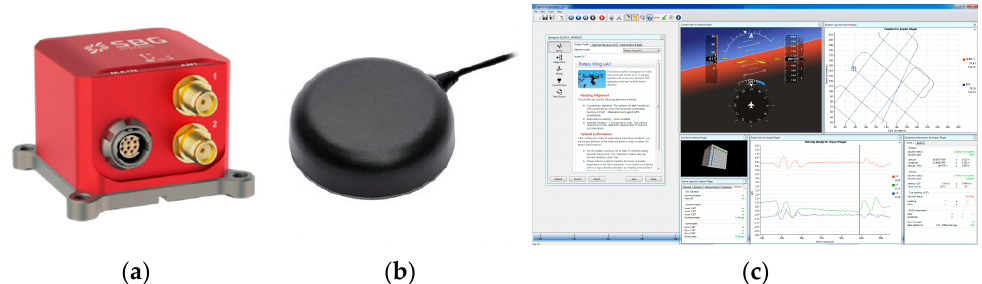
Figure 2. Components of the GNSS/INS system, model Ellipse-D, by the SBG Systems: ( a ) IMU, ( b ) GNSS antennas and ( c ) sbgCenter software [76].